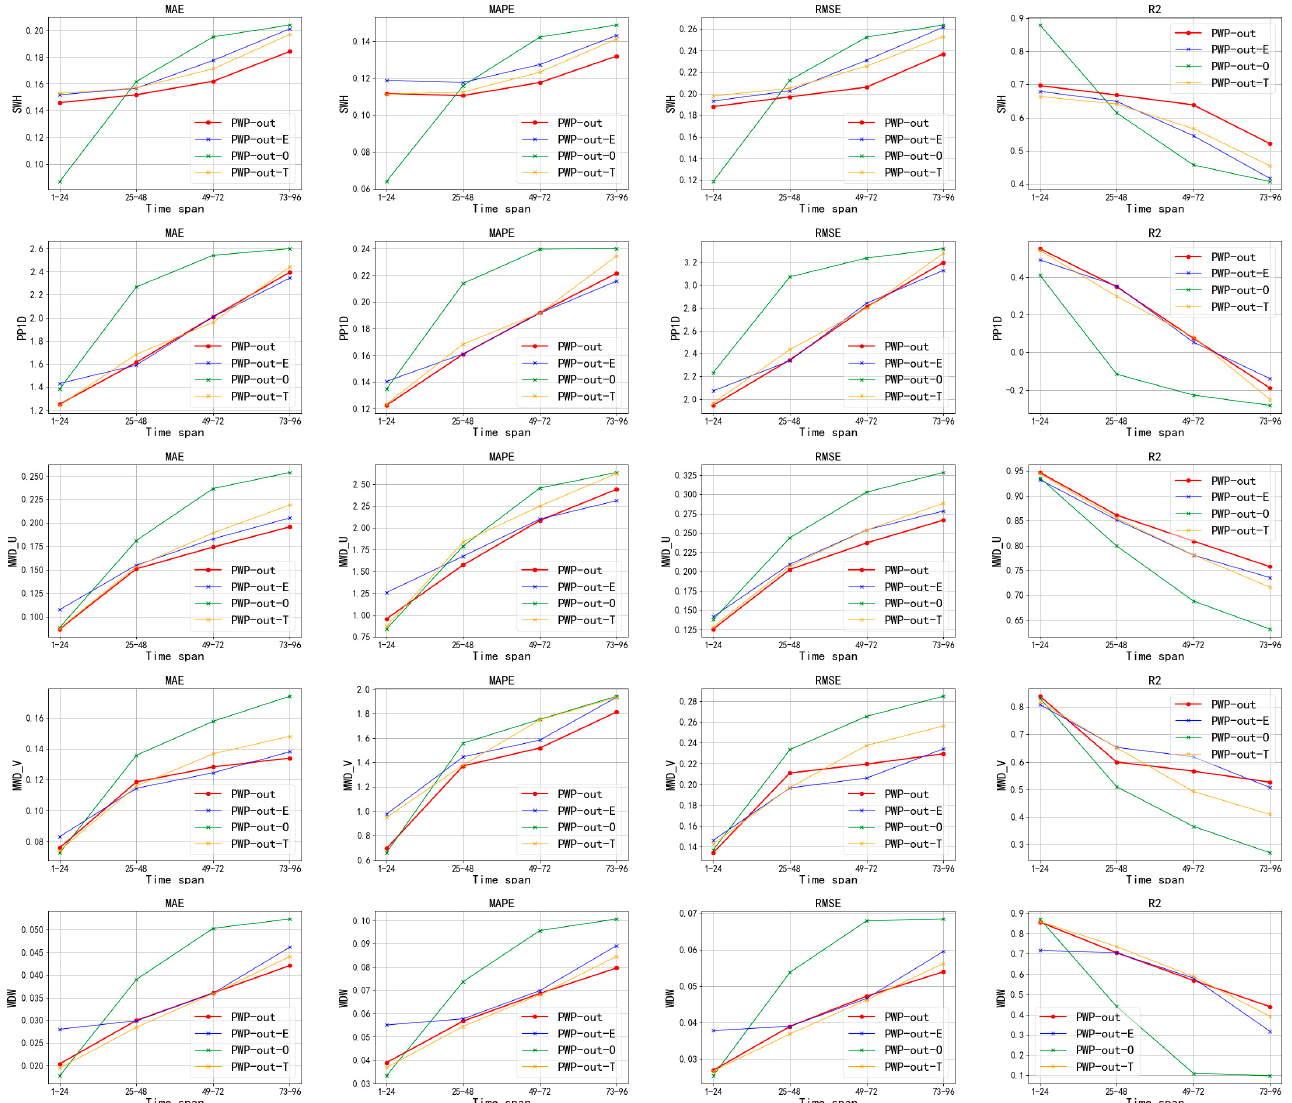
Figure 9. Performance comparison between PWP-out and other ablated models.